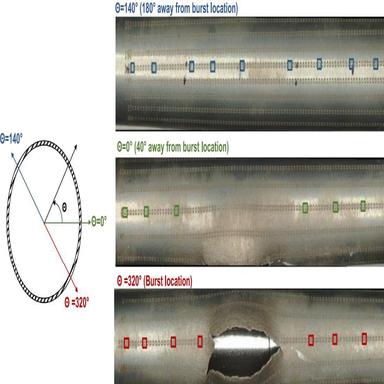
Surface image of the deformed sample at three different orientations. Squares represent where the DIC calculations were performed.